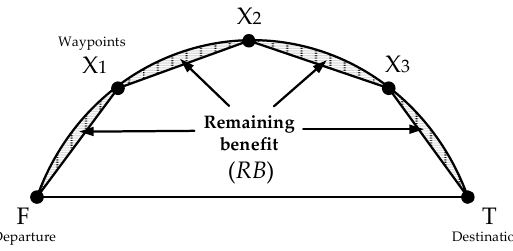
Figure 2. Schematic diagram of the remaining benefit ( 𝑅𝐵 ) of the GCR.